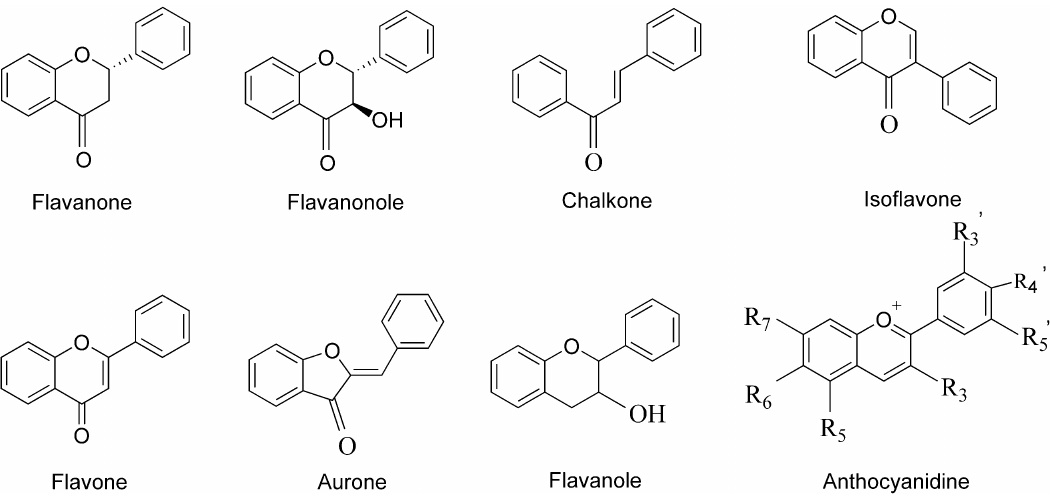
Figure 1. Structural formulae of flavonoids .